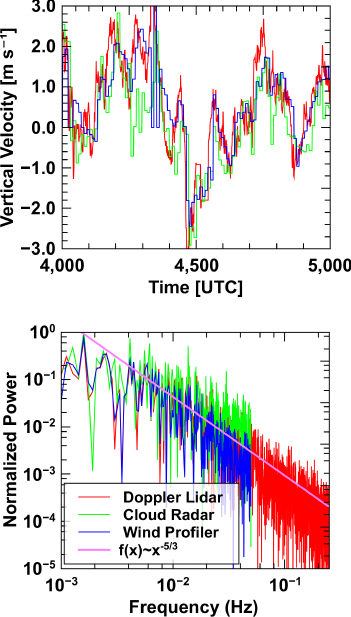
Figure 4. A combined vertical-velocity measurement from 30 July 2013, 09:45 to 11:15UTC at 1000m height (as indicated in Fig. 3 with a black line) is shown. Top panel shows a part of the vertical- velocity time series, the bottom panel shows the corresponding power spectra of the full time